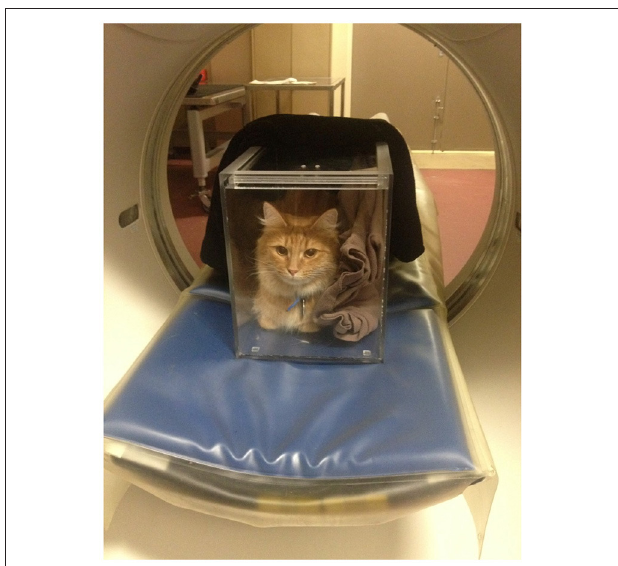
FIGURE 3 | A conscious cat is positioned in sternal recumbency in a plexiglass chamber for an abdominal CT scan. Blankets are placed in the box to act as wedges so that the patient is less tempted to move. The top sliding lid of the box is left ajar to ensure appropriate air flow during the examination.